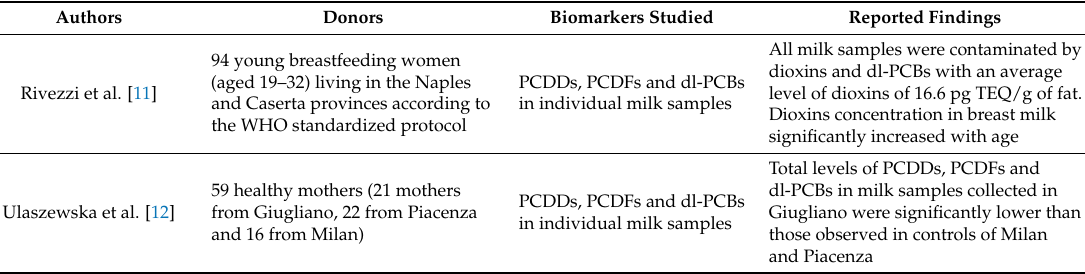
Table 1. Summary table of studies on human or animal